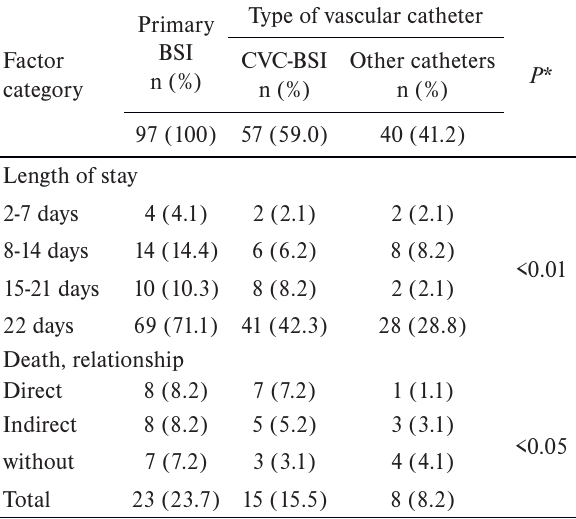
Table 2. Multivariate analysis of the incidence of primary bloodstream infections (BSI) and types of primary blood- stream infections.